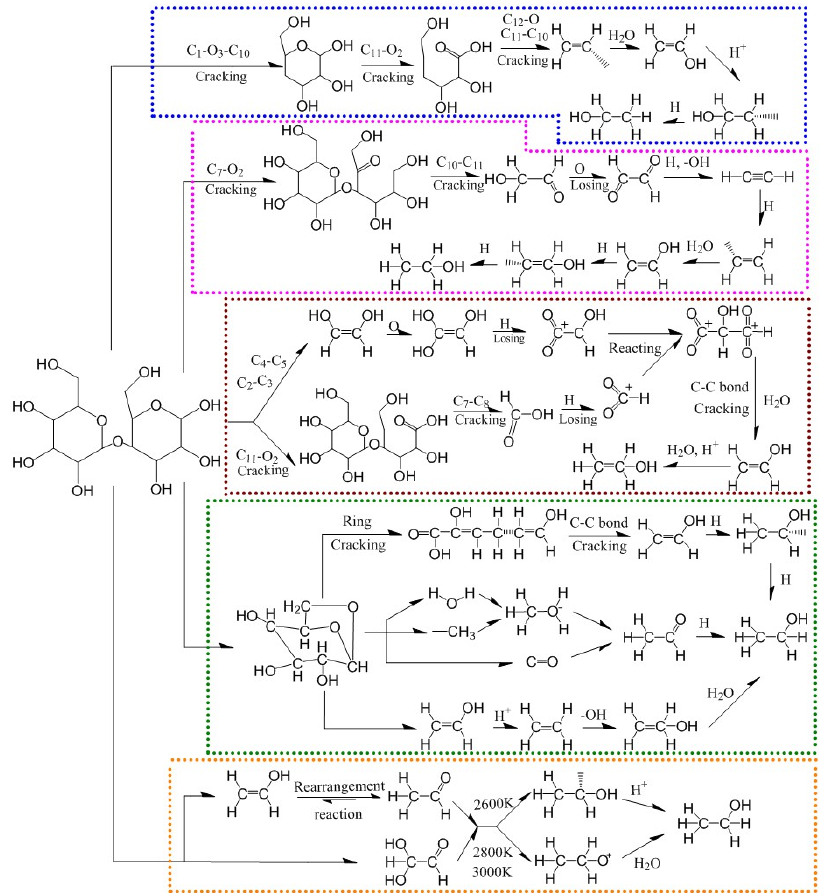
Figure 25. The pyrolysis path of cellobiose to generate ethanol.